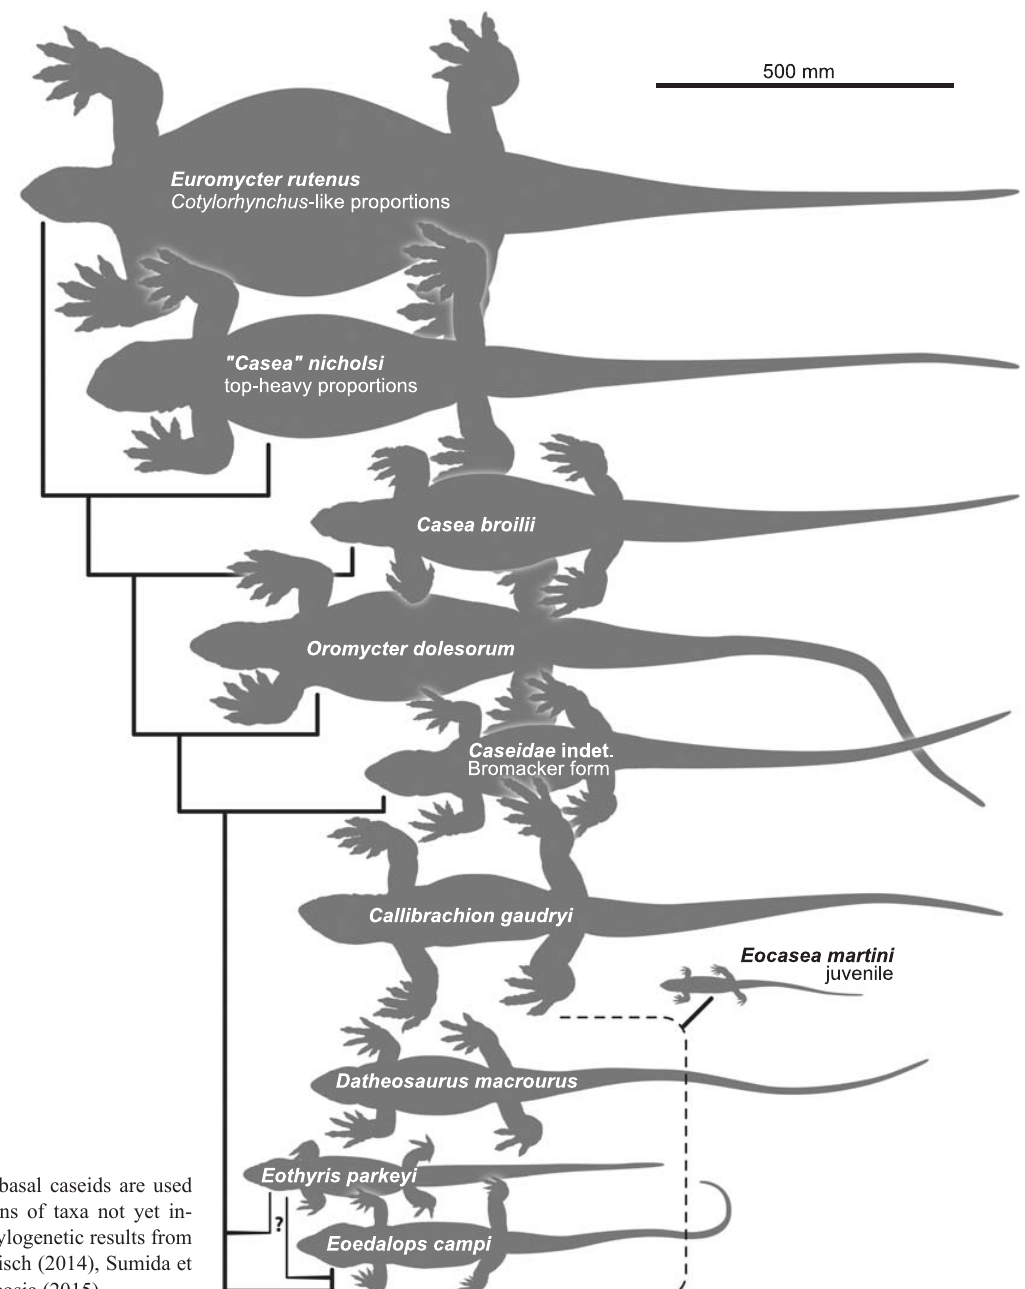
to suggest hypothetical positions of taxa not yet in- cluded to cladistic analyses. Phylo genetic results from Benson (2012), Reisz and Frö bisch (2014), Sumida et al. (2014), and Romano and Nicosia